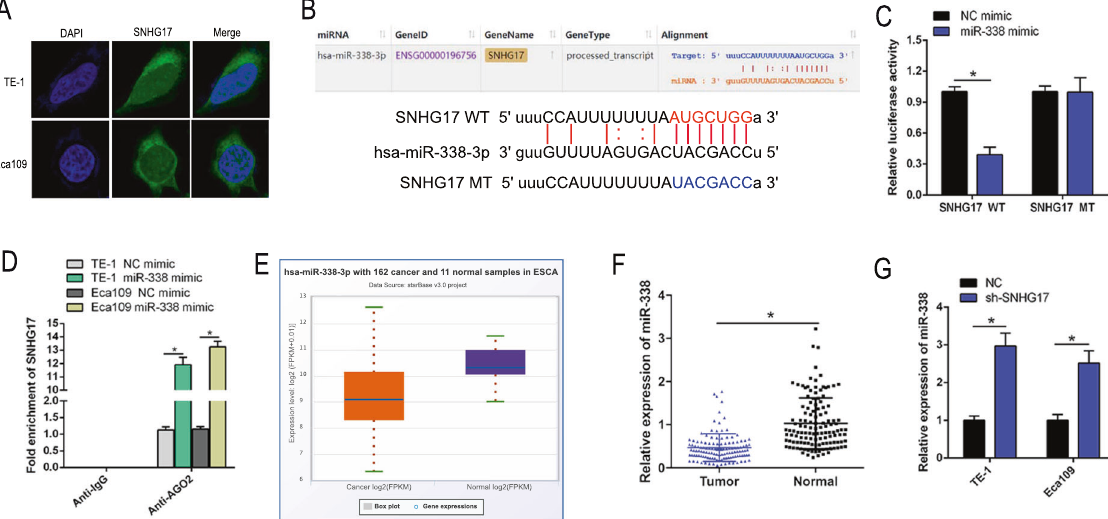
Fig. 3 SNHG17 could act as a ceRNA through binding to miR-338-3p. A RNA FISH assay of the cellular localization of SNHG17 (labeled in green) in TE-1 and Eca109 cells. B The bioinformatics analysis of miRNA database of SNHG17. C Relative luciferase activity is decreased in cells transfected with pGL3 ‐ SNHG17-WT and miR-338 mimic than in cells transfected with SNHG17-MT and miR-338 mimic, indicating that miR-338- 3p directly binds to SNHG17. * P < 0.05 vs. NC. D Interaction between SNHG17 and miR-338-3p was detected by RIP assay. E The data from starBase showed that miR-338-3p expression was downregulated in ESCC tissues compared to normal tissues. F The miR-338-3p expression was determined by RT-qPCR in clinical samples. * P < 0.05 vs. control group. G The RT-qPCR results showed that miR-338-3p expression level was increased by sh-SNHG17 in ESCC cells. * P < 0.05 vs.